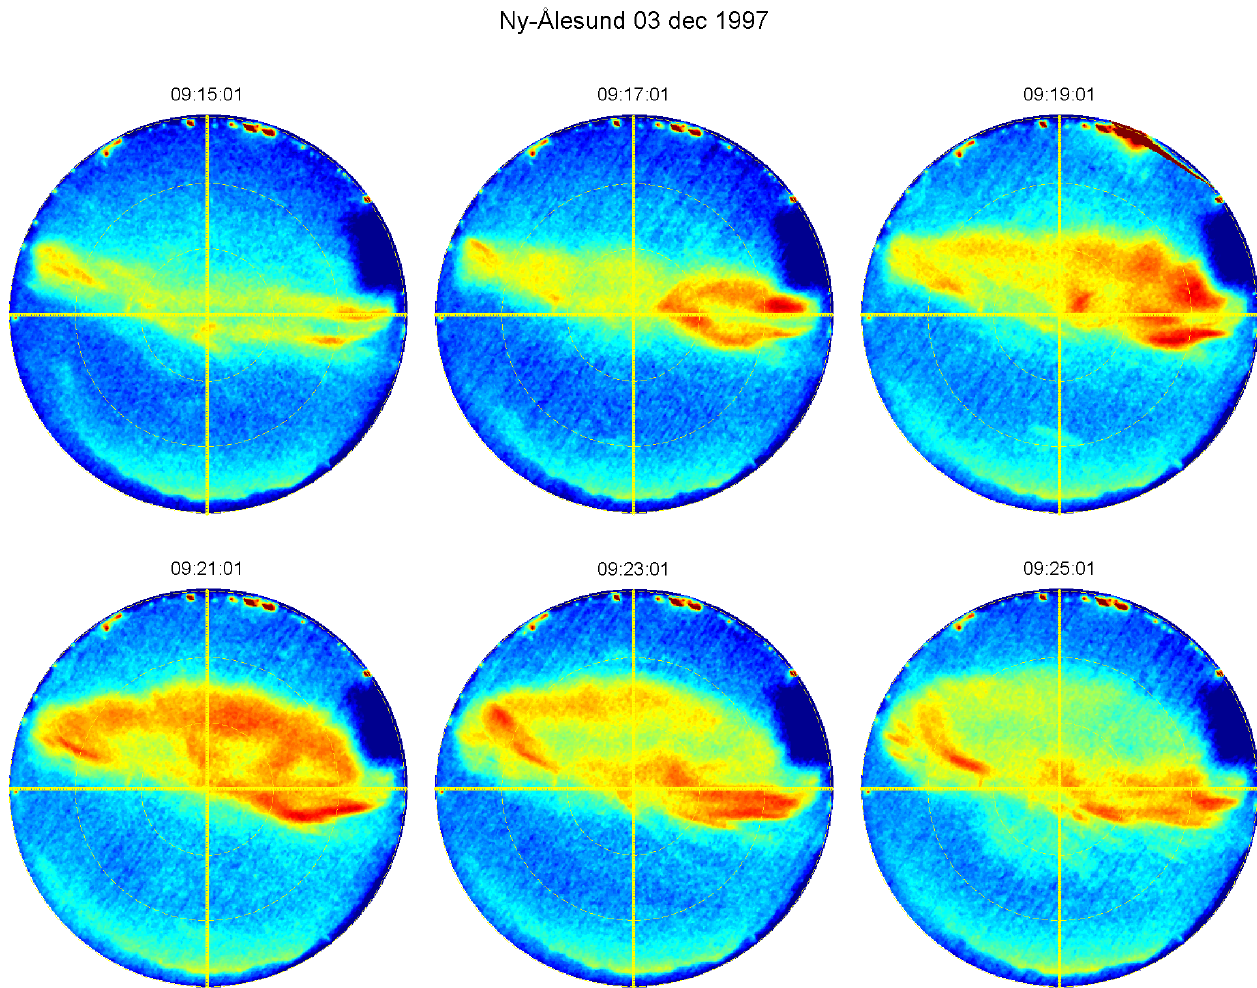
Fig. 7. ASC images at 630.0nm during the interval 09:15–09:25UT. The central vertical line marks the ∼ 12:45MLT meridian. Same format as in Fig.